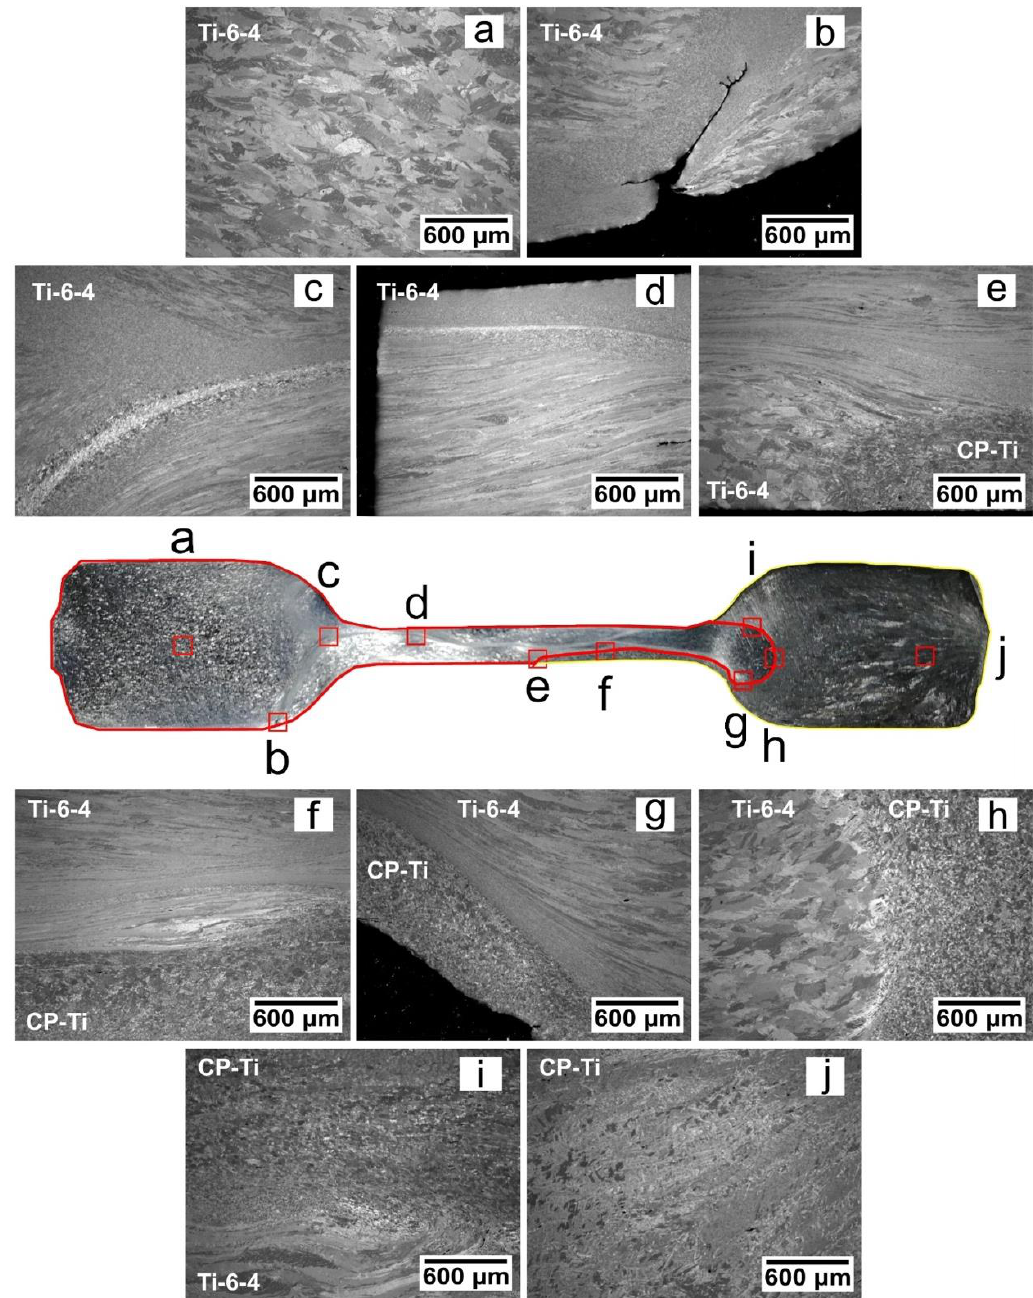
Figure 15. Light micrographs of regions of interest in the high strain cross-section of eye-bolt 1 (Ti-6-4 with CP-Ti): ( a ) Bulk Ti-6-4 microstructure; ( b ) exterior crack initiated due to excessive strain; ( c ) recrystallised Ti-6-4 region; ( d ) a comparison between a medium strain Ti-6-4 and high strain at the contact surface; ( e ) Ti-6-4 with CP-Ti interface at intermediate strains; ( f ) high strain bond interface for both alloys; ( g ) bond interface consisting of fine grained Ti-6-4 and small grained CP-Ti; ( h ) bond interface consisting of low strain Ti-6-4 and high strain CP-Ti; ( i ) bond interface consisting of low strain Ti-6-4 and high strain CP-Ti; and ( j ) bulk CP-Ti in an medium strained region.